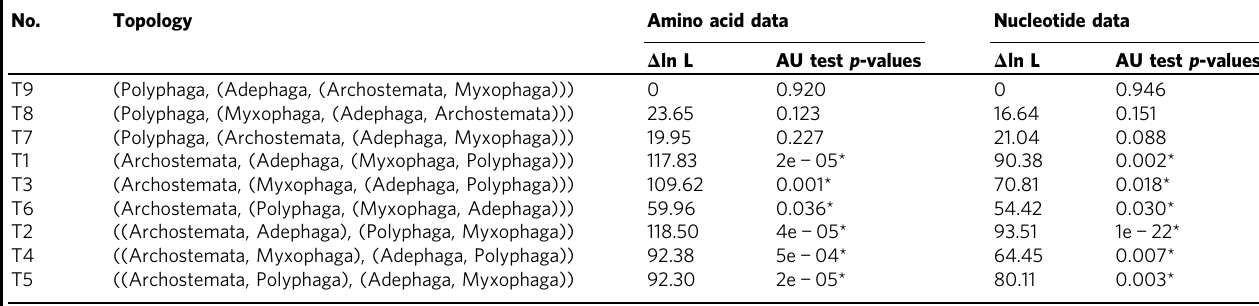
Table 1 Topology test for the nine proposed hypotheses among the four suborders of beetles